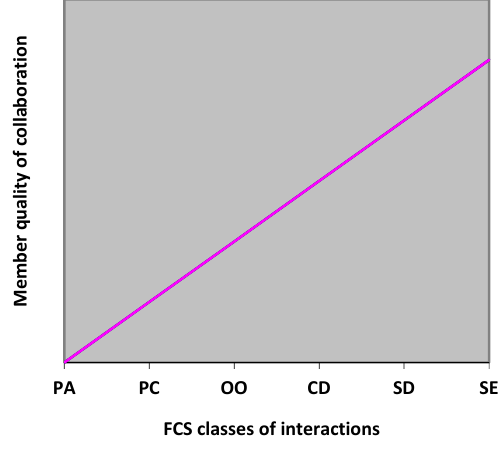
Figure 26. Member quality of collaboration assessment.